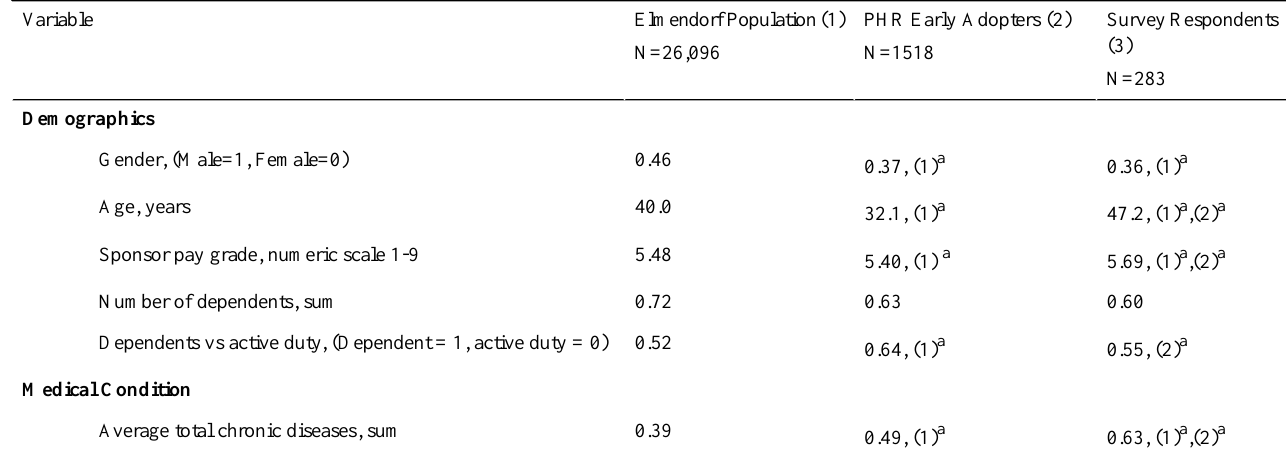
Table 1. Demographic profile of early adopters.